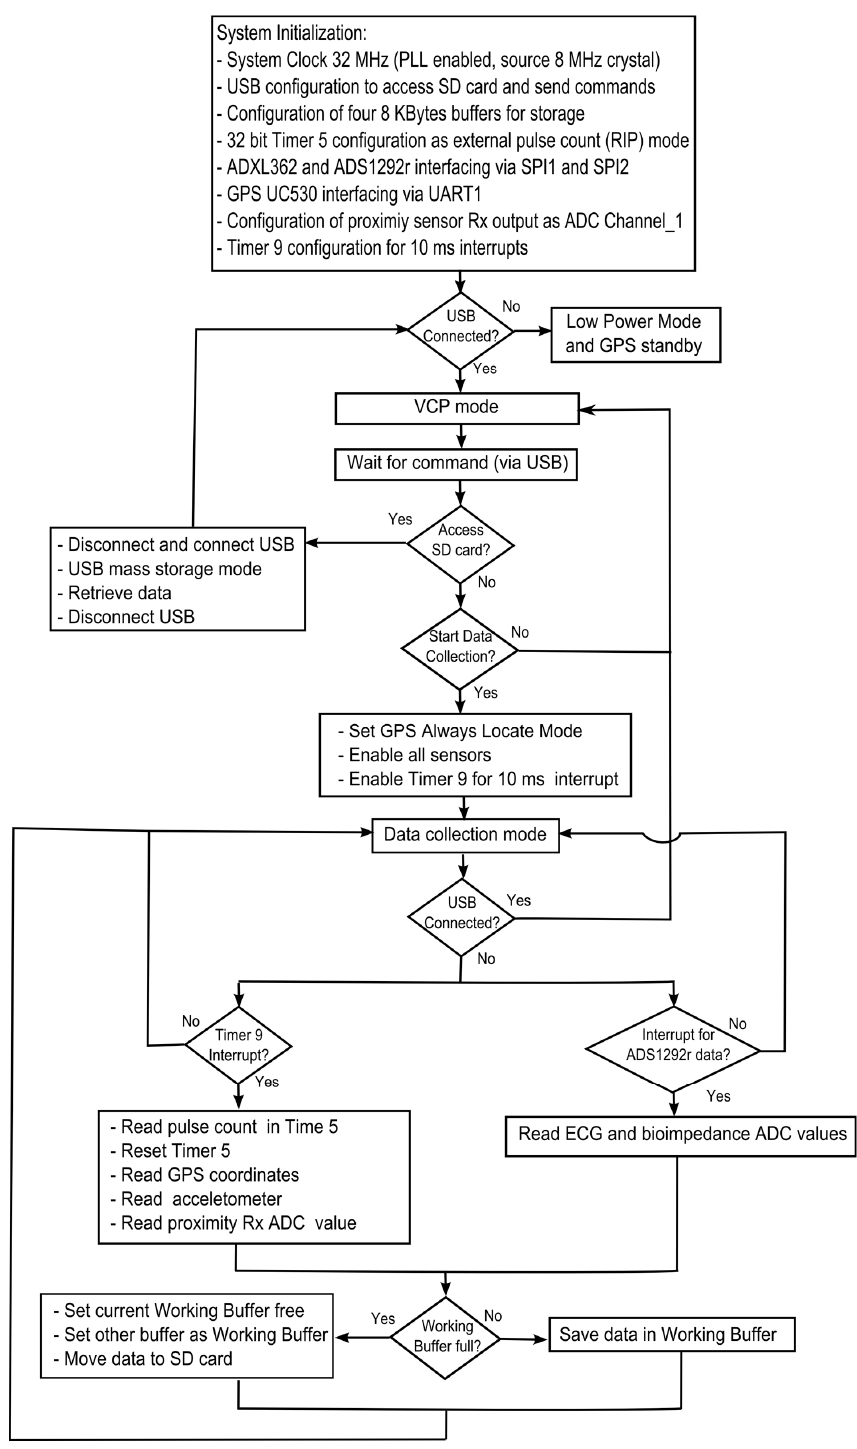
Figure 12. Chest module firmware.